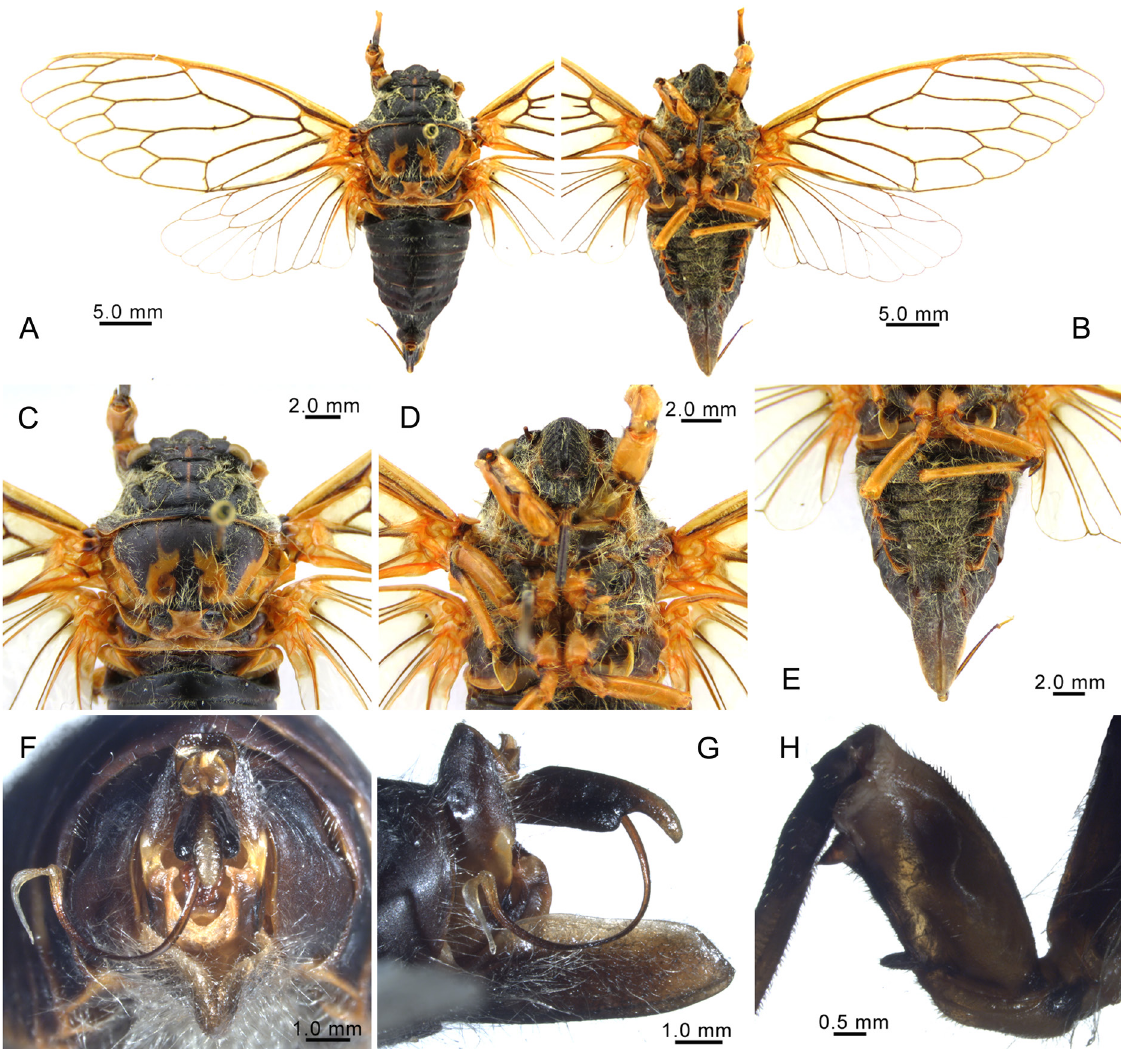
Fig. 1. Paharia oorschoti sp. nov. (♂, adult, holotype). A . Habitus, dorsal view. B . Habitus, ventral view. C . Head and thorax, dorsal view. D . Head and thorax, ventral view. E . Abdomen, ventral view. F . Male pygofer, ventral view. G . Male pygofer, lateral view. H . Left fore leg, showing the spines on fore